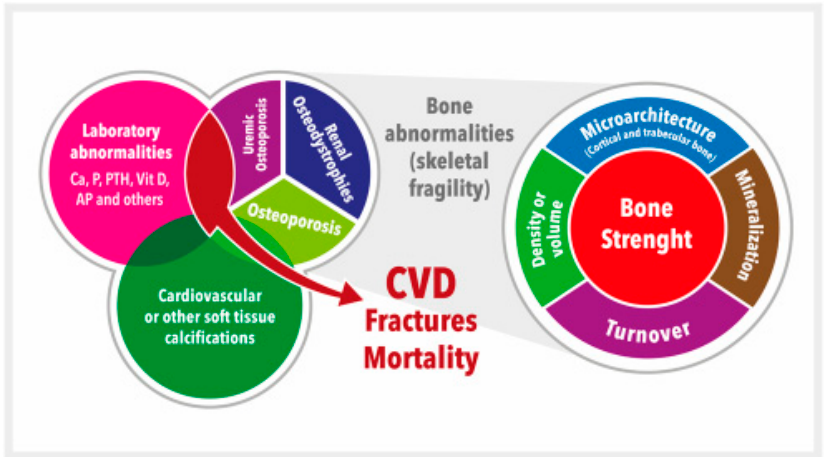
Figure 1. Schematic representation of the chronic kidney disease-mineral and bone disorder (CKD-MBD). CKD-MBD represents a systemic disorder of mineral and bone metabolism due to CKD manifested by either one or a combination of: (a) Laboratory abnormalities [calcium (Ca), phosphate (P), or vitamin D (vitD), among others (i.e., alkaline phosphatase, AP), etc.]; (b) Bone abnormalities in bone turnover, mineralization, volume, etc., ultimately affecting bone strength; and (c) Cardiovascular or other soft tissue calcifications. This figure illustrates the interrelated nature and consequences of CKD-MBD. The area occupied by different concepts is not associated with their relative importance. Adapted from S. Moe et al. (references [43,44]). CVD = Cardiovascular disease.